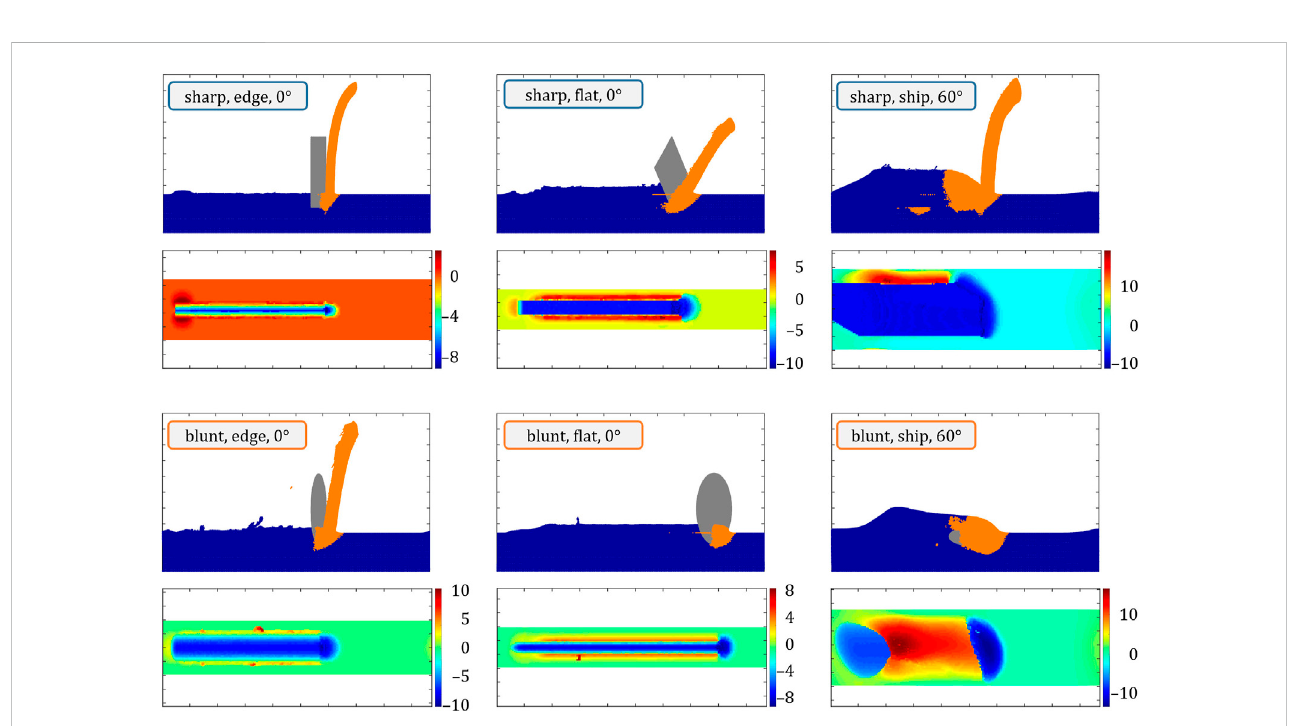
FIGURE 3 Abrasive orientation andshapedependenceofchipformation andmorphologyas wellasworkpiece topography at8 μ minfeeddepth. The colorbars of the topographic maps are in μ